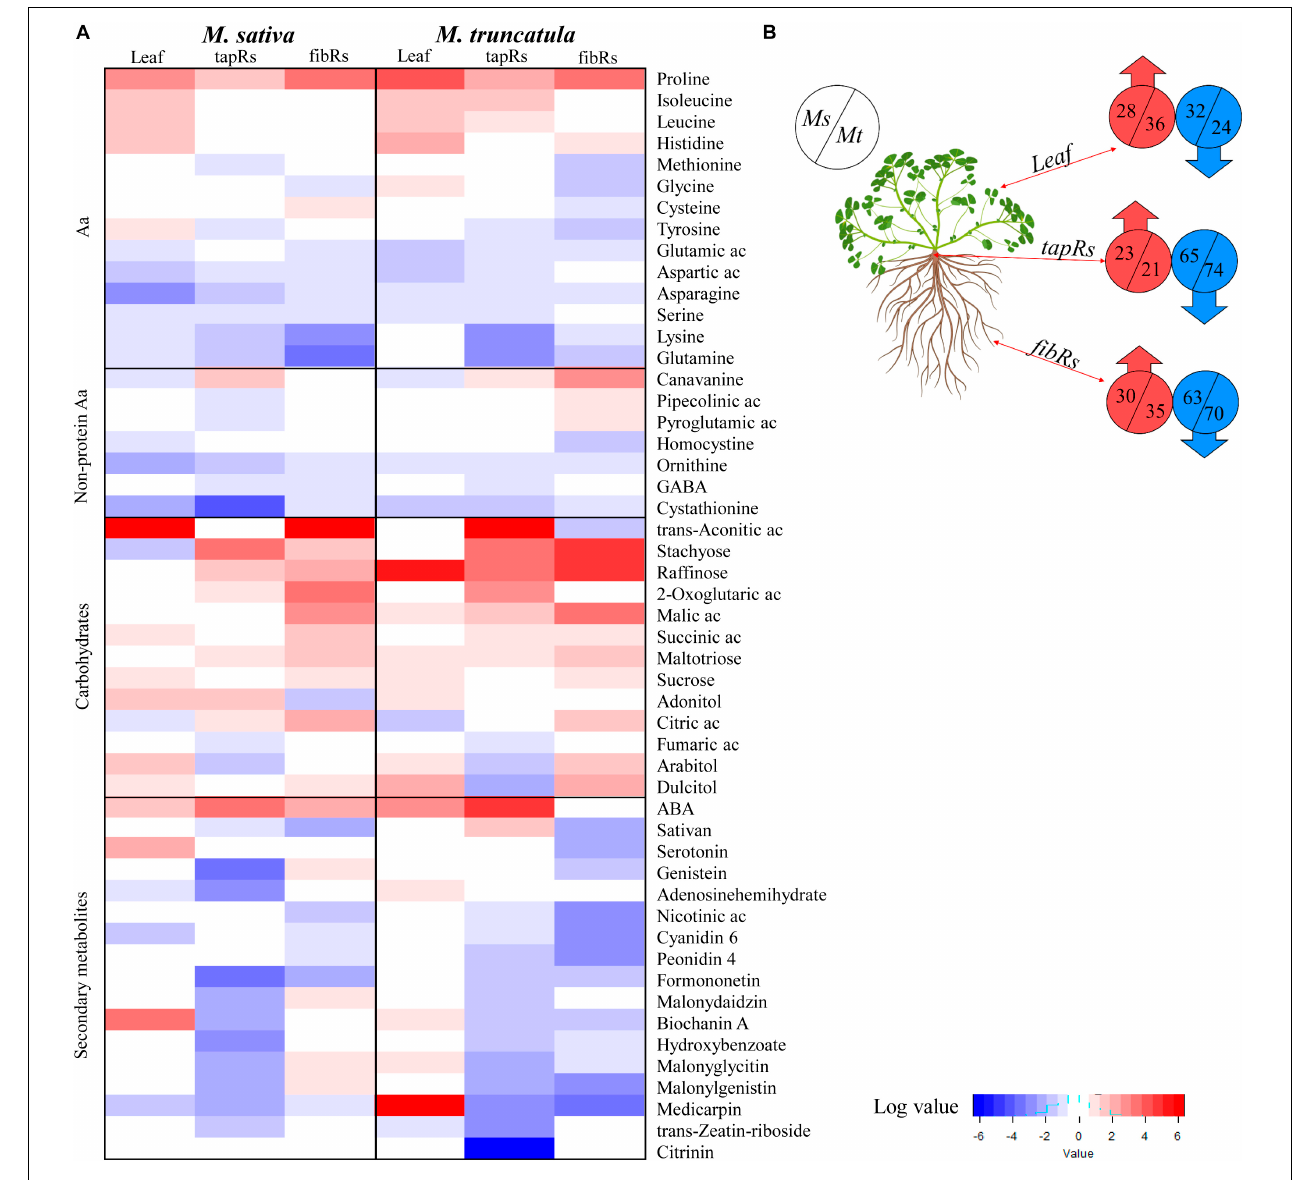
FIGURE 4 | Overview of the main metabolomic changes observed under water deficit conditions. (A) Heatmap representing metabolites whose content was significantly altered by water deficit (Student’s t -test; P ≤ 0.05) in leaves, taproots (tapRs), and fibrous roots (fibRs) of Medicago sativa ( Ms ) and M. truncatula ( Mt ). Values were expressed as log-transformed severe water deficit/control ratios (SD/C). Cut-offs were set to two-fold change for the amino acids and carbohydrates/organic acids, and ten-fold change for secondary metabolites. (B) Schematic representation of the number of metabolites showing a two-fold variation in leaves, tapRs, and fibRs of Ms and Mt plants under severe water deficit (SD) conditions. ABA, abscisic acid; Ac, acid; GABA, γ -aminobutyric acid. Plant image was created with